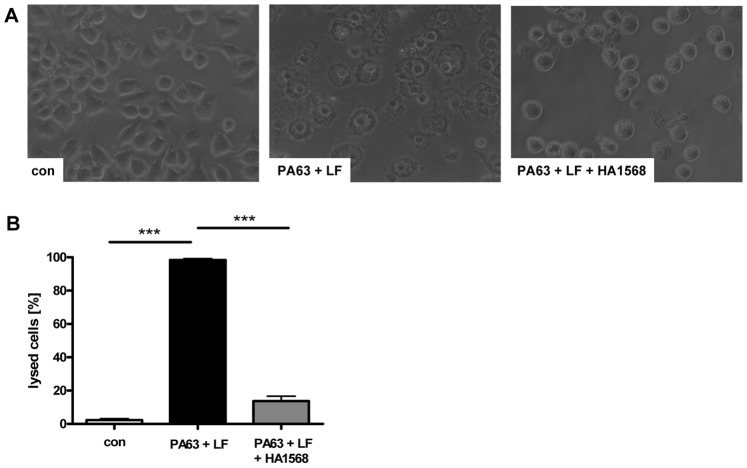
HA1568 protects J774A.1 cells against the cytotoxic effect of PA63/LF. J774.A1 cells were incubated for 30 min at 37°C with 100 µM of HA1568 and subsequently PA63 (1 µg/mL) plus LF (1 µg/mL) were added to the medium. A. Cells were further incubated in the presence of the toxin and HA1568 at 37°C and pictures were taken after 2 h. B. The percentage of lysed cells was determined from the pictures. Data are given as mean ± S.D (n = 3; *** = p<0.0005).